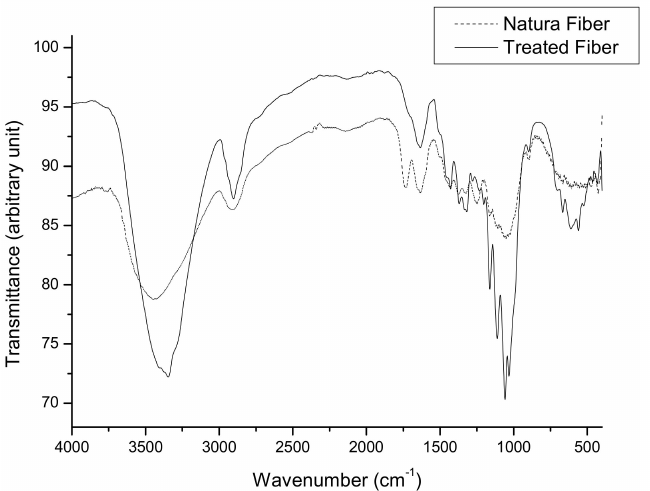
Figure 2. Infrared spectra of the sisal fiber.